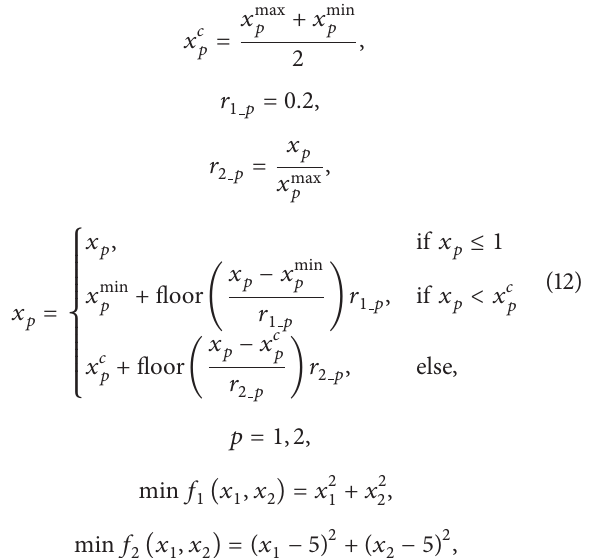
Table 1: The fuzzy reference points given by DMs for M-BINH. Decision maker ( 𝐷 𝑗